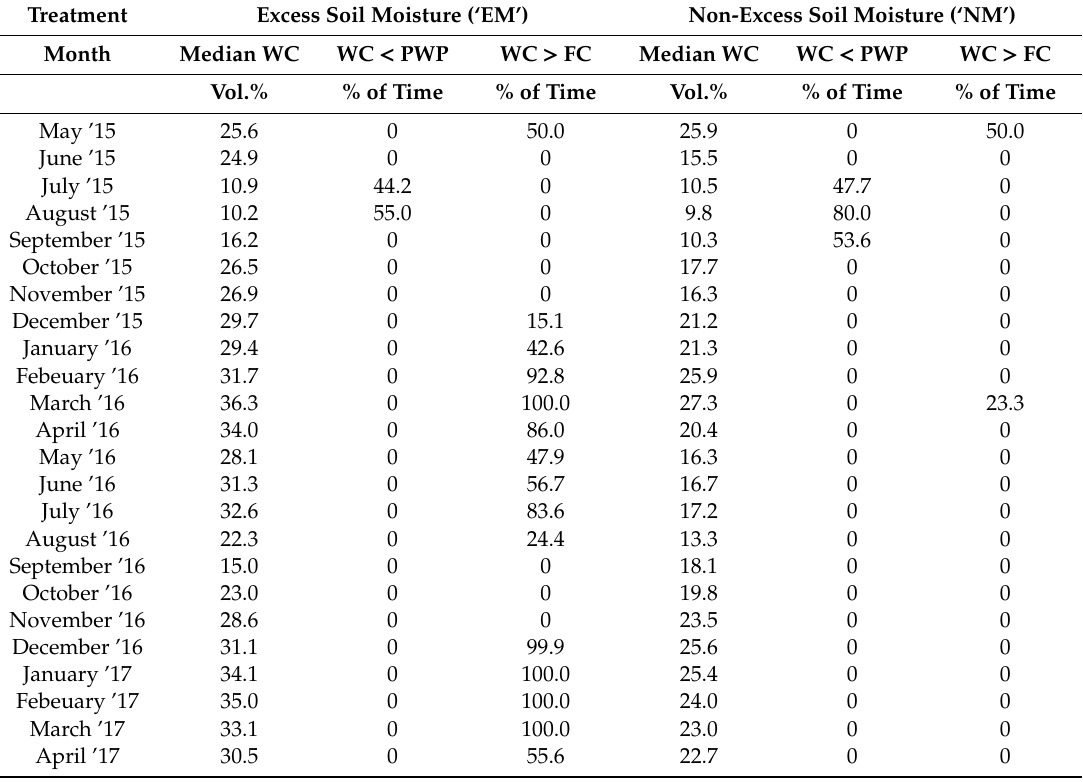
Table 3. Summary of volumetric soil water contents (WCs) on a monthly basis for both treatments during the experimental period. Median values of volumetric soil water content, proportional exceedances of the permanent wilting point (WC < PWP, pF < 4.2, WC < 10.3 vol.%) and field capacity (WC > FC, pF > 1.8, WC > 30.4 vol.%) are